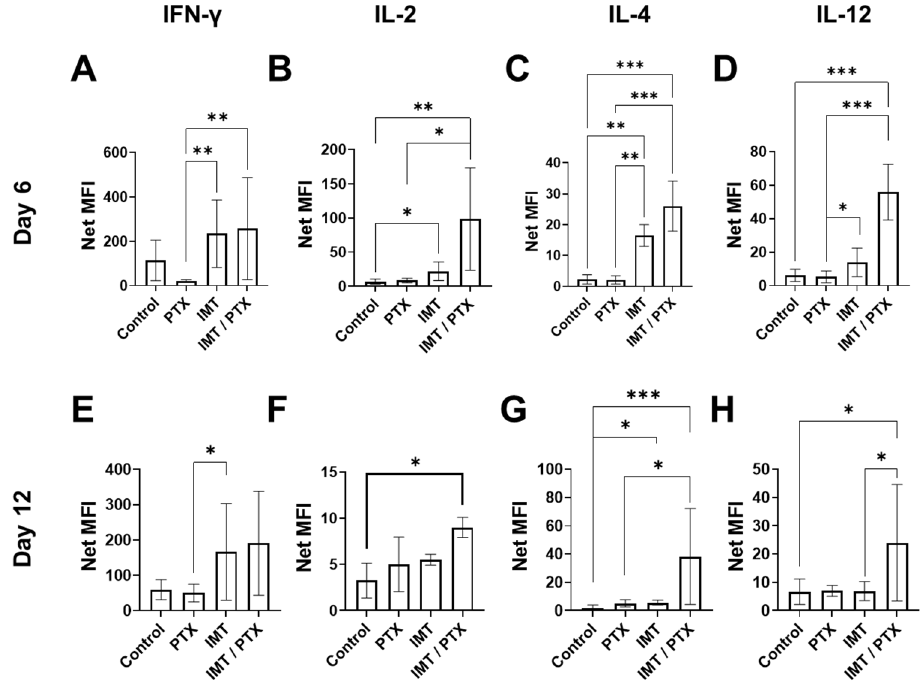
Figure 6. Combination immunotherapy/paclitaxel increases Th1/2 response to stimulate effector cell activation in E0771 tumors. E0771 tumors ( n = 3/group) were extracted from mice on days 6 ( A – D ) and 12 ( E – H ) before significant changes in tumor volume. Mean ± SD (* indicates p < 0.05, ** indicates p < 0.001, *** indicates p < 0.0001; Dunn’s test). Abbreviations: Interleukin (IL), mean fluorescence intensity (MFI).